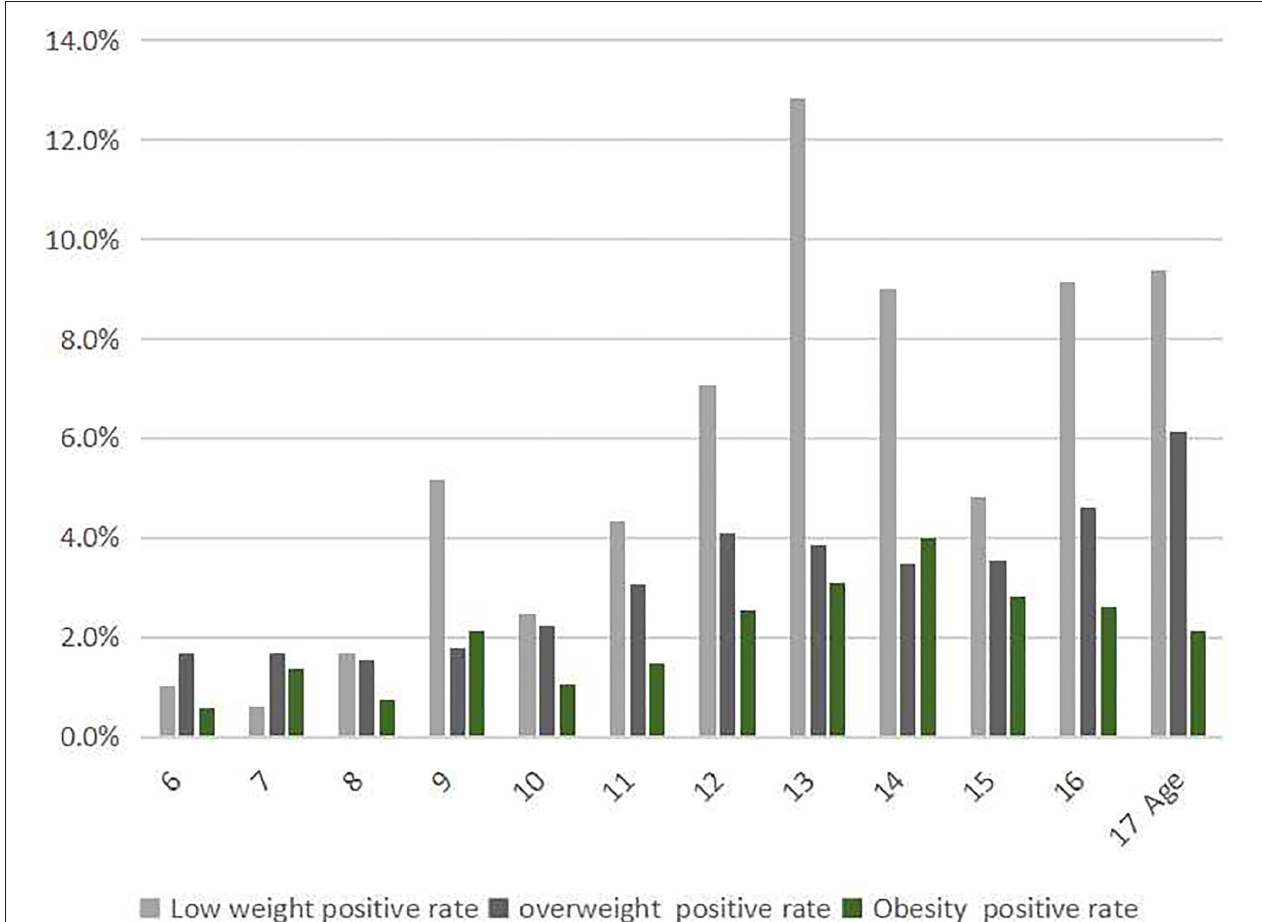
FIGURE 3 | The prevalence of scoliosis screening positive among children and adolescents stratified by nutritional status.